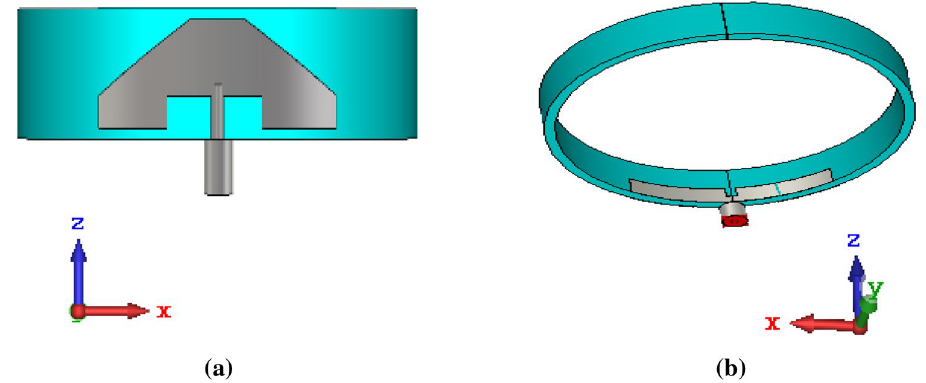
Figure 1. Proposed antenna ( a ) front view and ( b ) rear view.